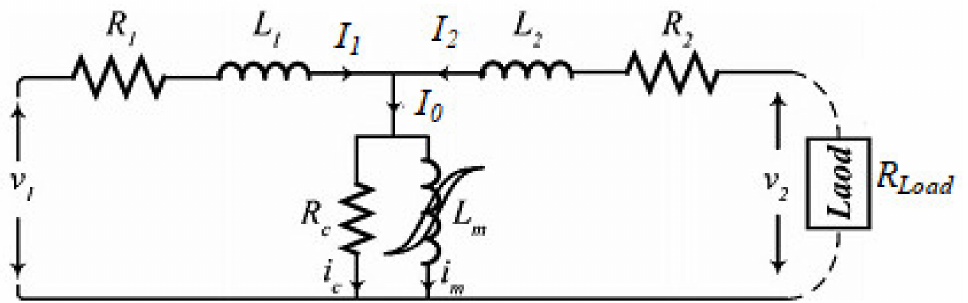
Figure 1. Single-phase transformer equivalent circuit under steady-state